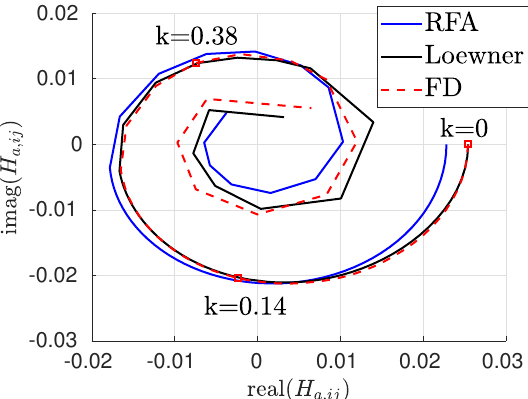
Figure 10. Element of the transfer function matrix from the gust input to the lift coefficient for the strip at the wing station y = 13.48 (m).